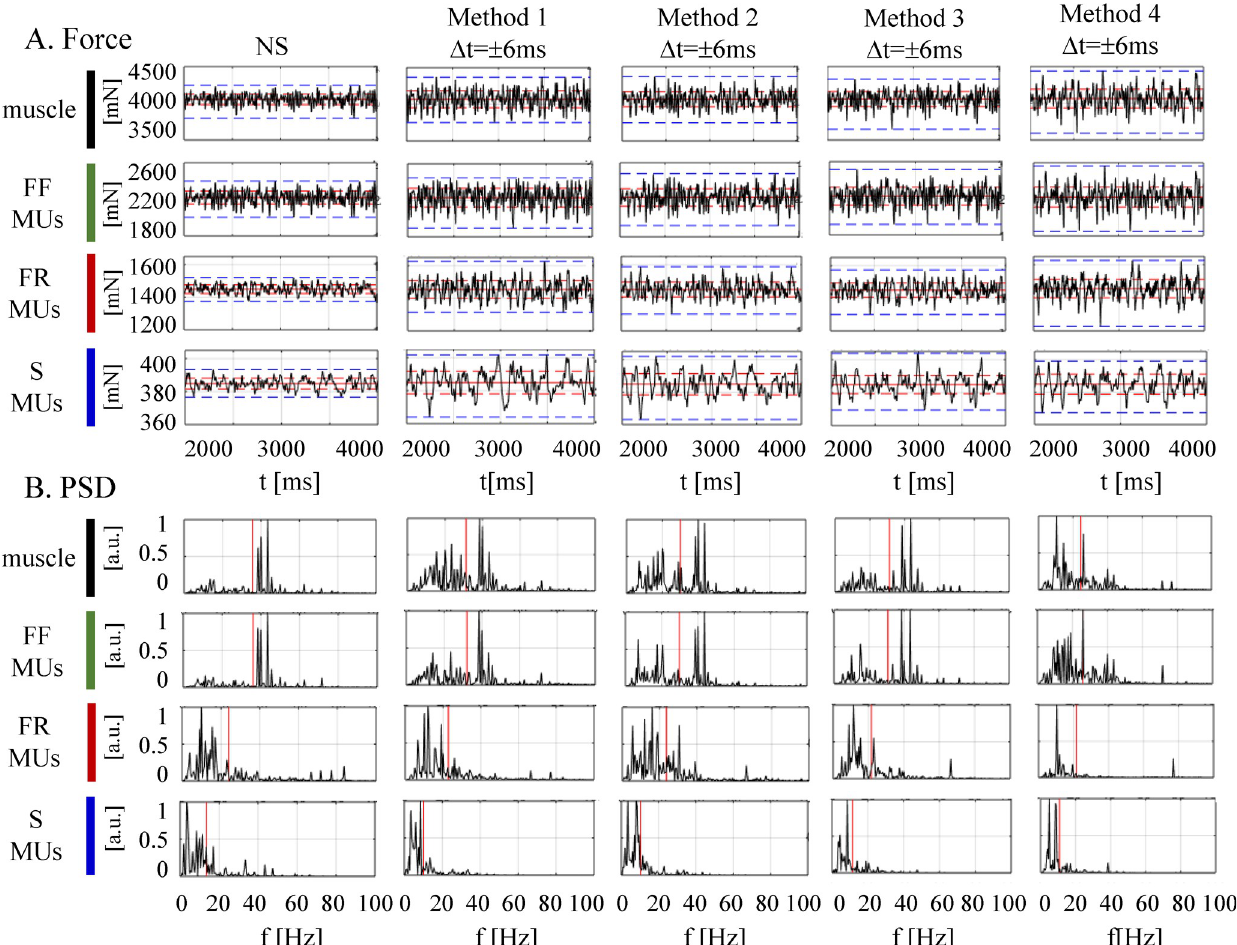
Fig 8. The forces (A) and respective power spectral densities–PSD—(B) calculated for the muscle and different MU types (S, FR, and FF) during the muscle steady state of the NS excitation and by using four methods of MU synchronization ( Δ t ± 6 ms). Values of different force parameters are indicated in each box of panel A as follows: the mean force by a red horizontal solid line, the force rms by a red horizontal dotted line, and the force range by a blue horizontal dotted line; meanwhile, the mean frequency is indicated in each box of panel B by a red vertical thick